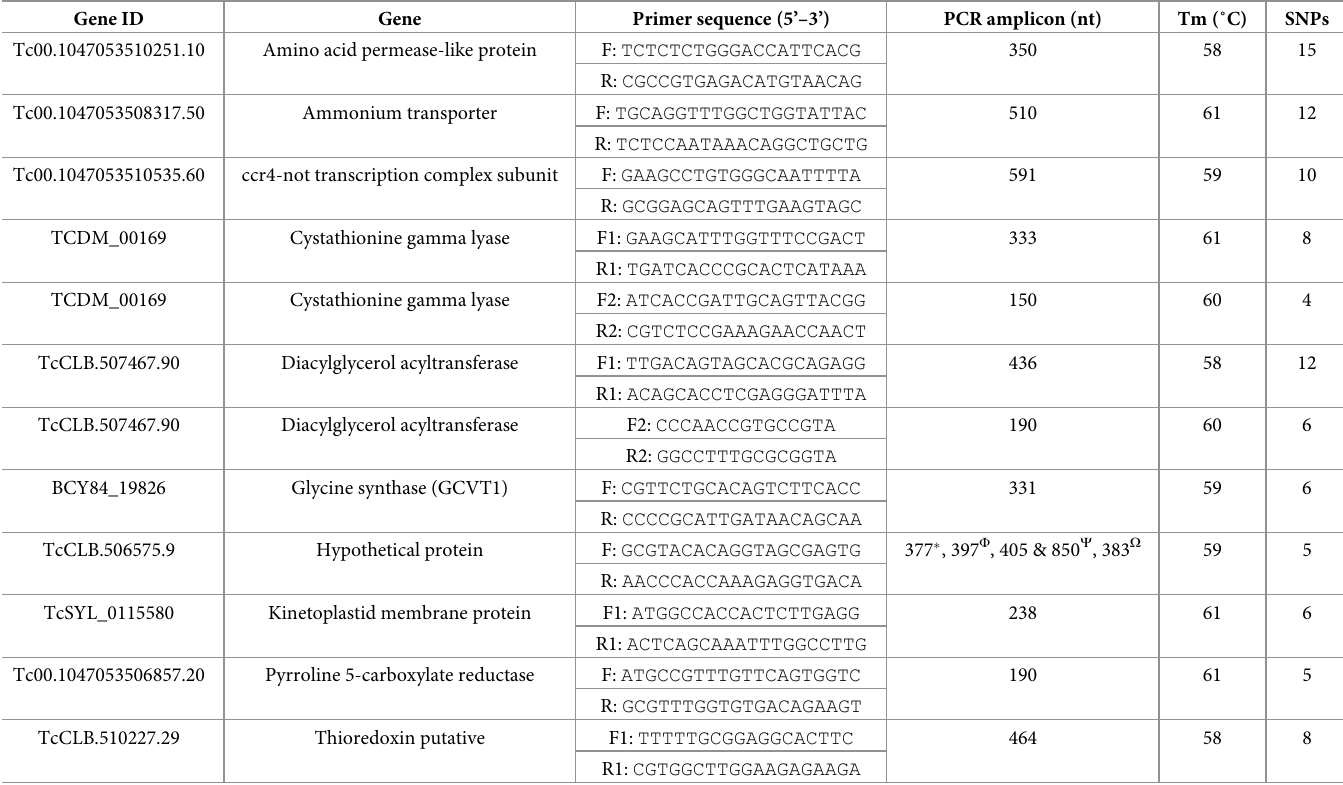
Table 1. Characteristics of molecular markers selected.